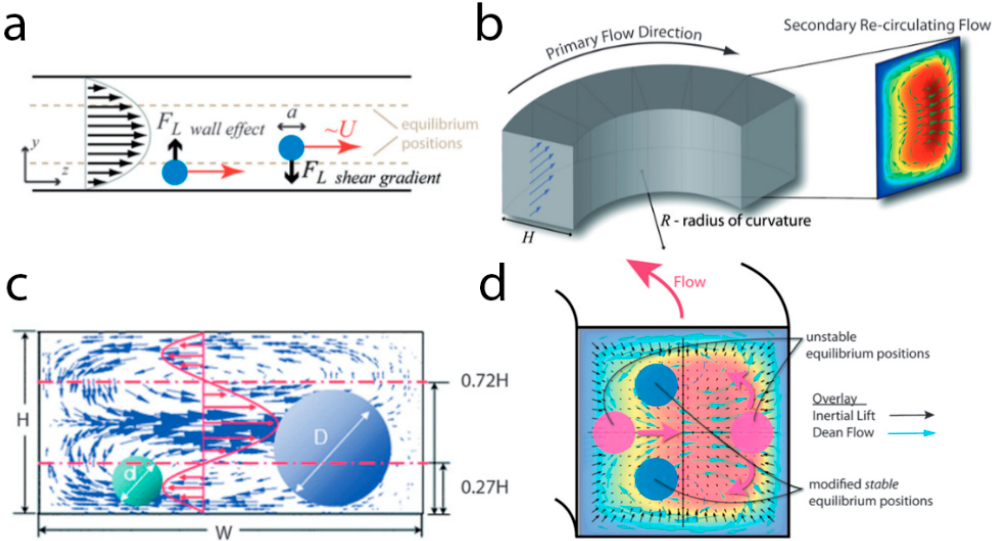
Figure 15. ( a ) Formation of the hydrodynamic equilibrium position of a cell moving in the liquid flow and affected by the drag and lift forces; ( b ) formation of re-circulating secondary flow (Dean flow) in the curved microchannel; ( c ) separation of the cells depending on their size employing secondary flow in curved microchannel; ( d ) the shift of the equilibrium position due to the superposition of inertial lift and Dean flow in a curved microchannel. Adapted with permission from [297] Copyright 2001, the Royal Society of Chemistry.